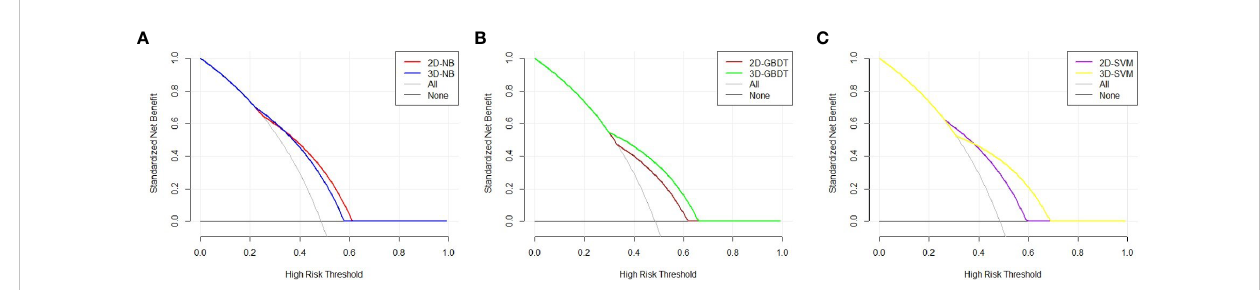
FIGURE 4 Decision curve analysis of the two models in each machine learning classify. The X axis represents the threshold probability, and the Y axis represents the net bene fi t. The 2D model has a better performance than 3D model in NB, because 2D model has a larger net bene fi t than 3D model across most range of the threshold probability (A) . The 3D model performs better than 2D model in GBDT due to its larger net bene fi t in all the threshold probability (B) . An intersection of two models at the point of nearly 0.4 can be found in SVM. The 2D model has a better performance at the left of the intersection, while 3D model has a better performance at the right of the intersection (C)